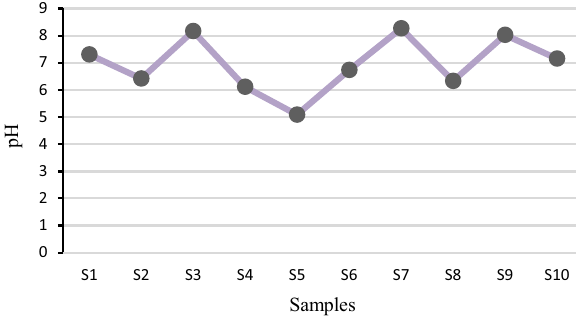
Fig. 4 Average electrical conductivity values of analyzed dairy efflu- ents